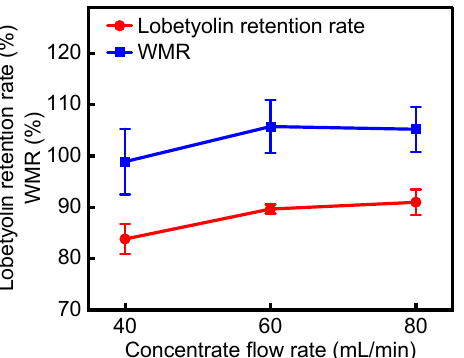
Figure 8. WMR values and lobetyolin retention rates under different concentrate flow rate on the micromesh mixer. The results are expressed as mean ± standard deviations, n = 3.